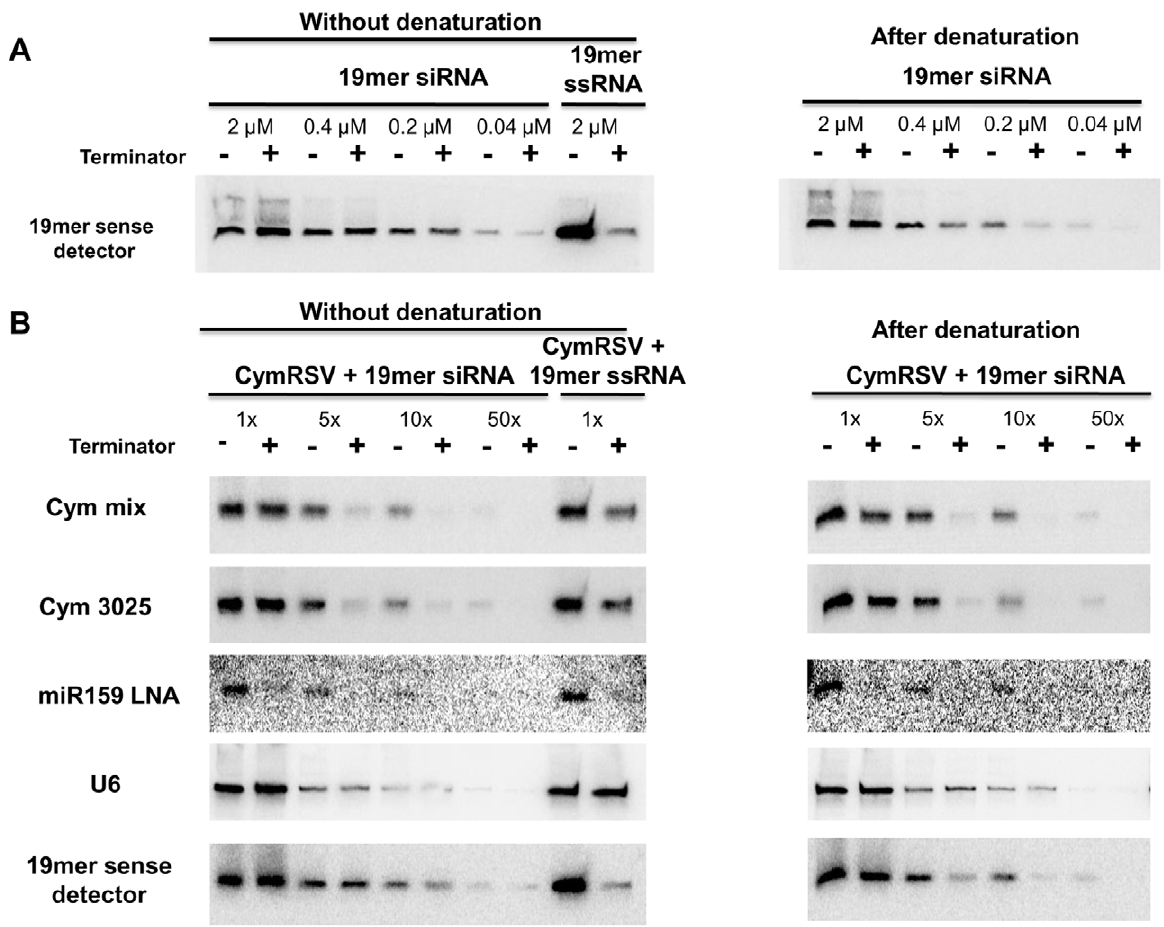
Figure 2. Terminator digest of synthetic siRNAs and vsiRNAs. A 19mer in vitro synthesised and phosphorylated siRNA was digested with Terminator TM 5 9 -Phosphate-Dependent Exonuclease in decreasing concentration without (left panel) or after denaturation (right panel)(A). The sense strand of the phosphorylated 19mer RNA oligonucleotide was digested in the highest concentration as a control for phosphorylation. The efficiency of the digestion was monitored by northern blot assay using a probe complementary to the sense strand of the synthetic siRNA. Total RNA from CymRSV infected N. benthamiana plants was mixed with the 19mer in vitro synthesised and phosphorylated siRNA and digested with Terminator TM 5 9 -Phosphate-Dependent Exonuclease in decreasing concentration without (left panel) or after denaturation (right panel) (B). The sense strand of the phosphorylated 19mer RNA was also mixed with total RNA from CymRSV infected N. benthamiana plants and digested in the highest concentration. The efficiency of the digestion was monitored by northern blot assay using probes complementary to the minus strand of the virus (Cym mix, a pool of five probes or Cym 3025), miR159, U6 snRNA or the sense strand of synthetic siRNA, respectively.